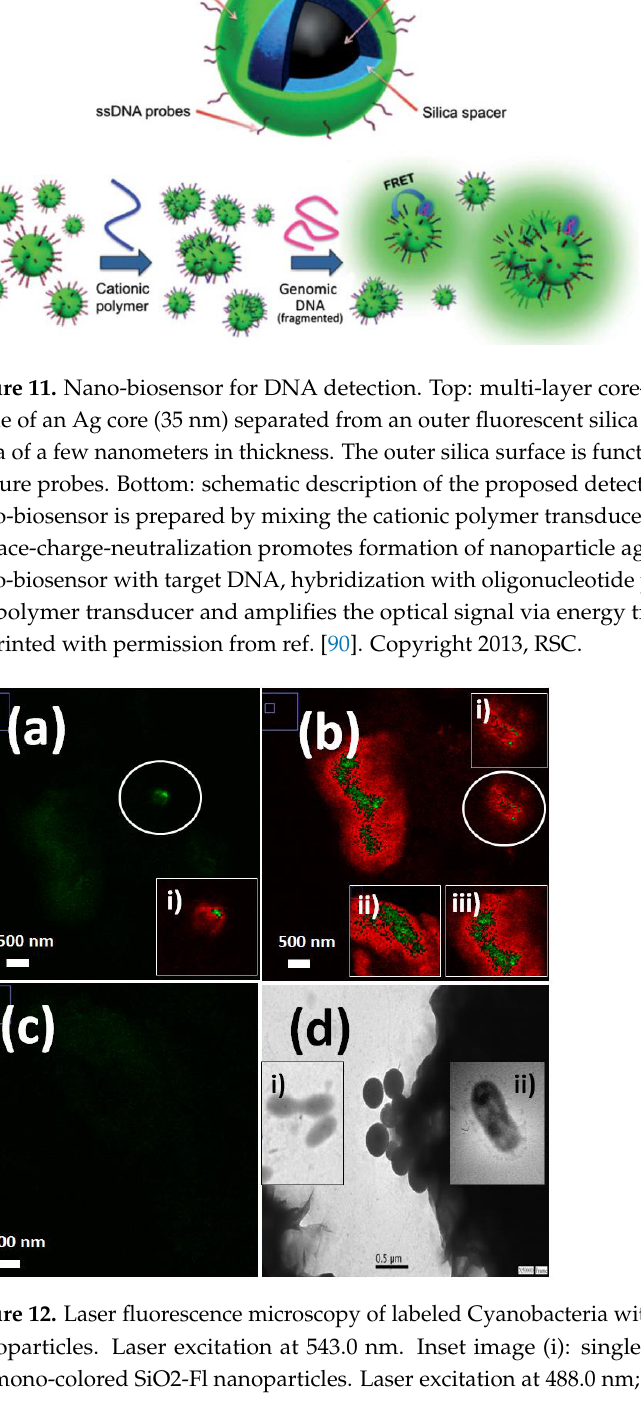
15 of 28 Figure 10. Scheme of modified substrate with optical active nanomaterials including quantum graphene dots within a metamaterial substrate for coupling and waveguiding. Reprinted with permission from ref. [88]. Copyright 2022, Current Material Science (CMS)-Recent Patents on Ma- terials Science Label-free DNA biosensing based on the accurate control of plasmonic cores and MEF could also be considered. Thus, the nanoarchitecture based on multilayer fluores- cent nanocomposites was optimized using a polymeric transducer [89]. The size of silver cores, spacer lengths, and donor/acceptor spectroscopical properties was tuned. The op-